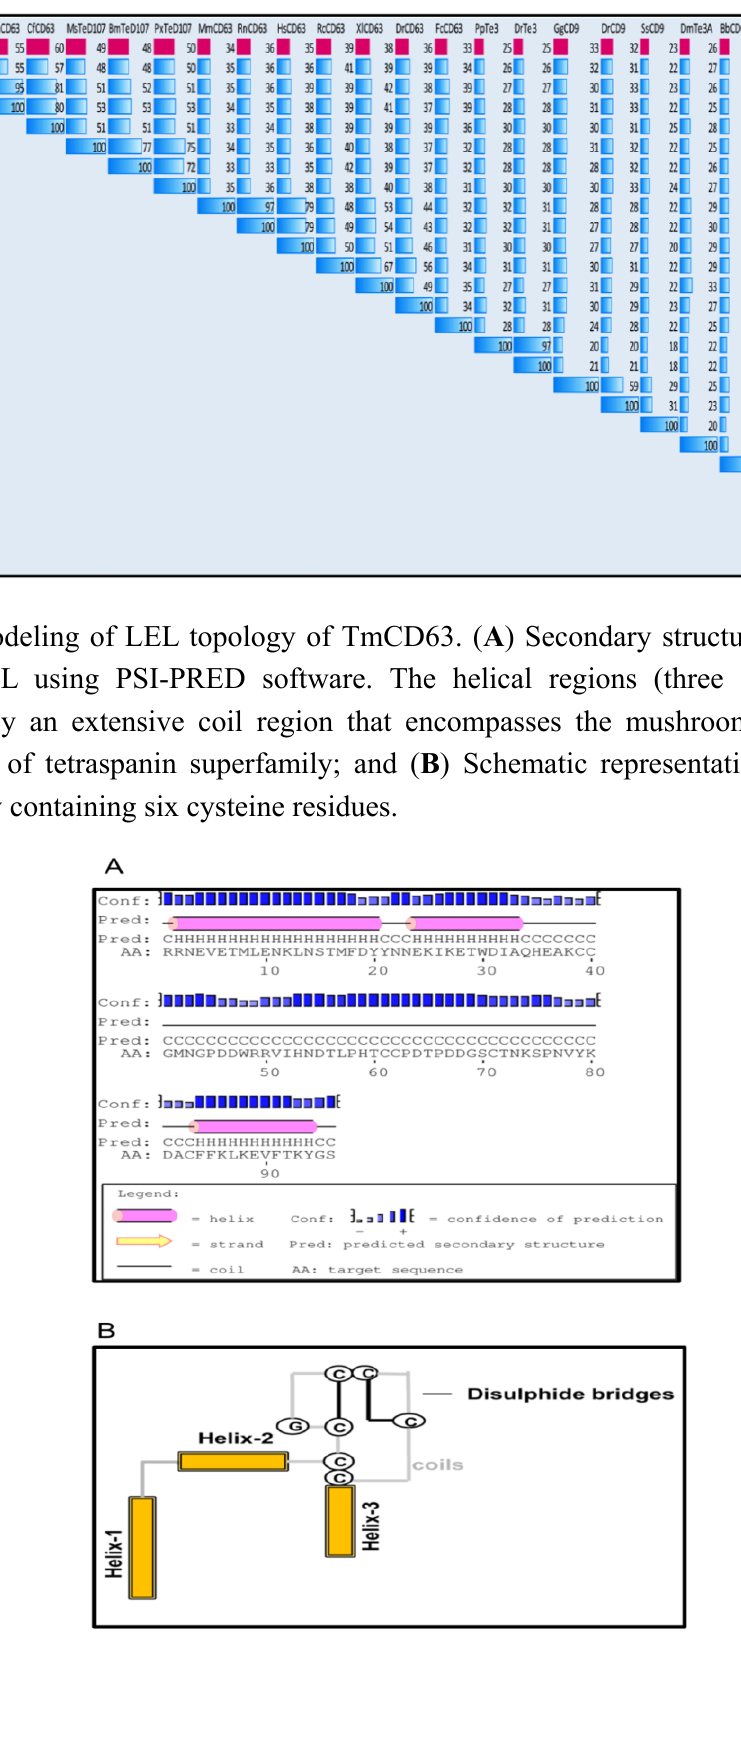
Figure 5. Percentage pairwise identities of TmCD63 with tetraspanin amino acid sequences from various animals including insects. The percentage identities have been highlighted using blue data bars with red bars indicating identities of TmCD63.